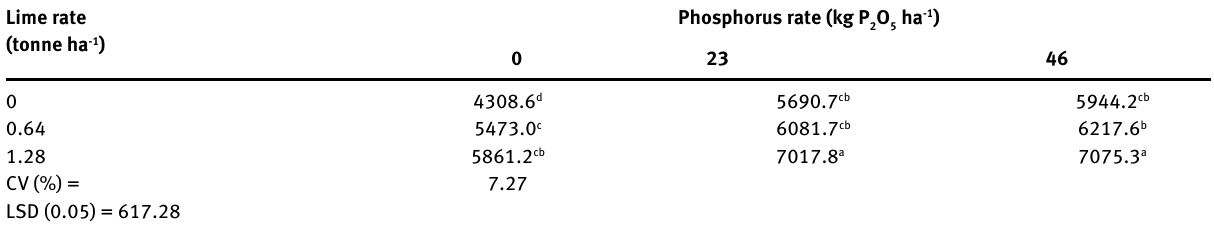
Table 8. Interaction effect of lime and phosphorus on aboveground dry matter yield during long rainy season Lime